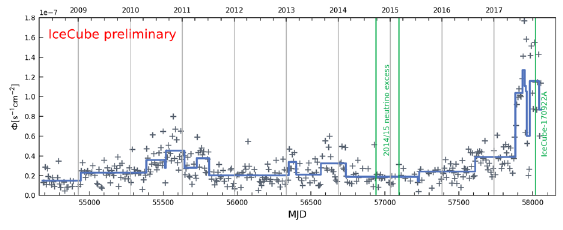
Figure 1. Lightcurve of TXS 0506 + 056 for gamma-ray energies > 700 MeV. Grey crosses (NB: not error bars) are the base lightcurve produced by LLH fits to the flux normalisation of the source in 7-day bins. The blue line is the resulting lightcurve after denoising with Bayesian blocks. Vertical green lines represent the EHE neutrino IceCube-170922A and the time window of the neutrino excess in 2014 /